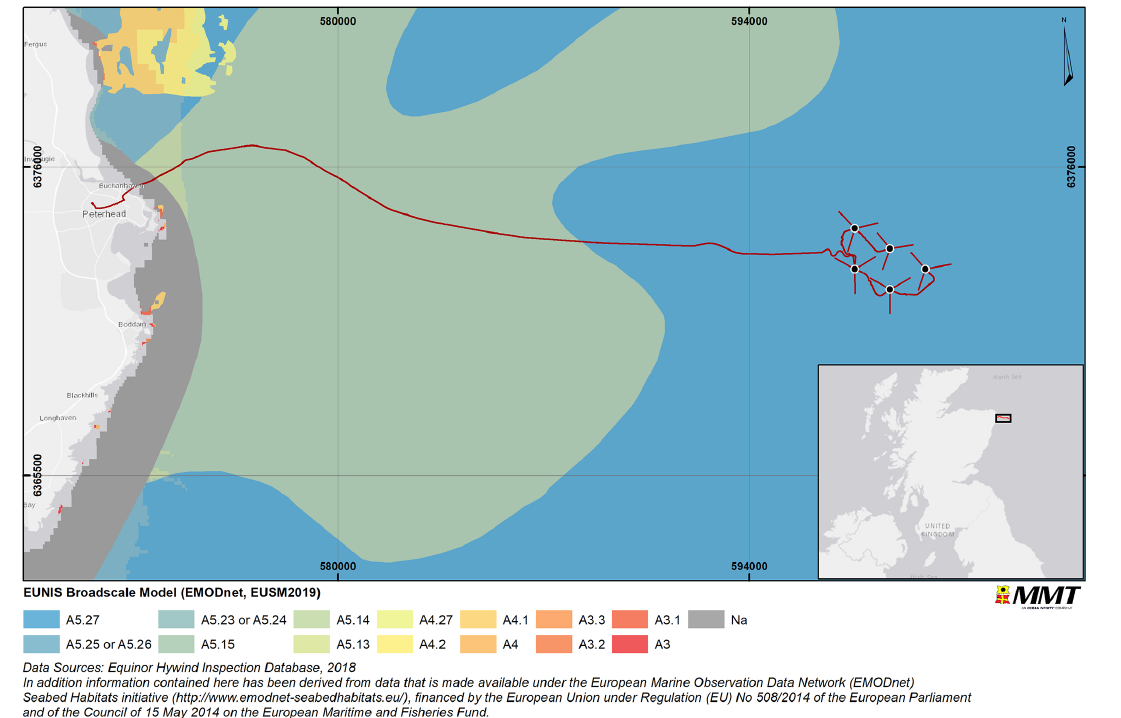
Figure 1. Overview of the survey area and habitat according to the EUNIS (European Union Nature Information System; EUSM2019: EUSeaMap 2019) classification. The main habitat found in the survey area is A5.27 (deep circalittoral sand). Other habitats found are A5.25 (circalittoral fine sand), A5.26 (circalittoral muddy sand), A5.23 (infralittoral fine sand), A5.24 (infralittoral muddy sand), A5.15 (deep circalittoral coarse sediment), A5.14 (circalittoral coarse sediment), A5.13 (infralittoral coarse sediment), A4.27 (faunal communities on deep moderate-energy circalittoral rock), A4.2 (Atlantic and Mediterranean moderate-energy circalittoral rock), A4.1 (Atlantic and Mediterranean high-energy circalittoral rock), A4 (circalittoral rock and other hard substrata), A3.3 (Atlantic and Mediterranean low-energy infralittoral rock), A3.2 (Atlantic and Mediterranean moderate-energy infralittoral rock), A3.1 (Atlantic and Mediterranean high-energy infralittoral rock), A3 (infralittoral rock and other hard substrata) and Na (not applicable). Basemap sources: © OpenStreetMap contributors 2021. Distributed under the Open Data Commons Open Database License (ODbL)